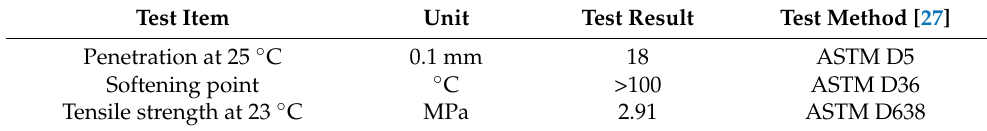
Table 6. Performance parameters of the epoxy